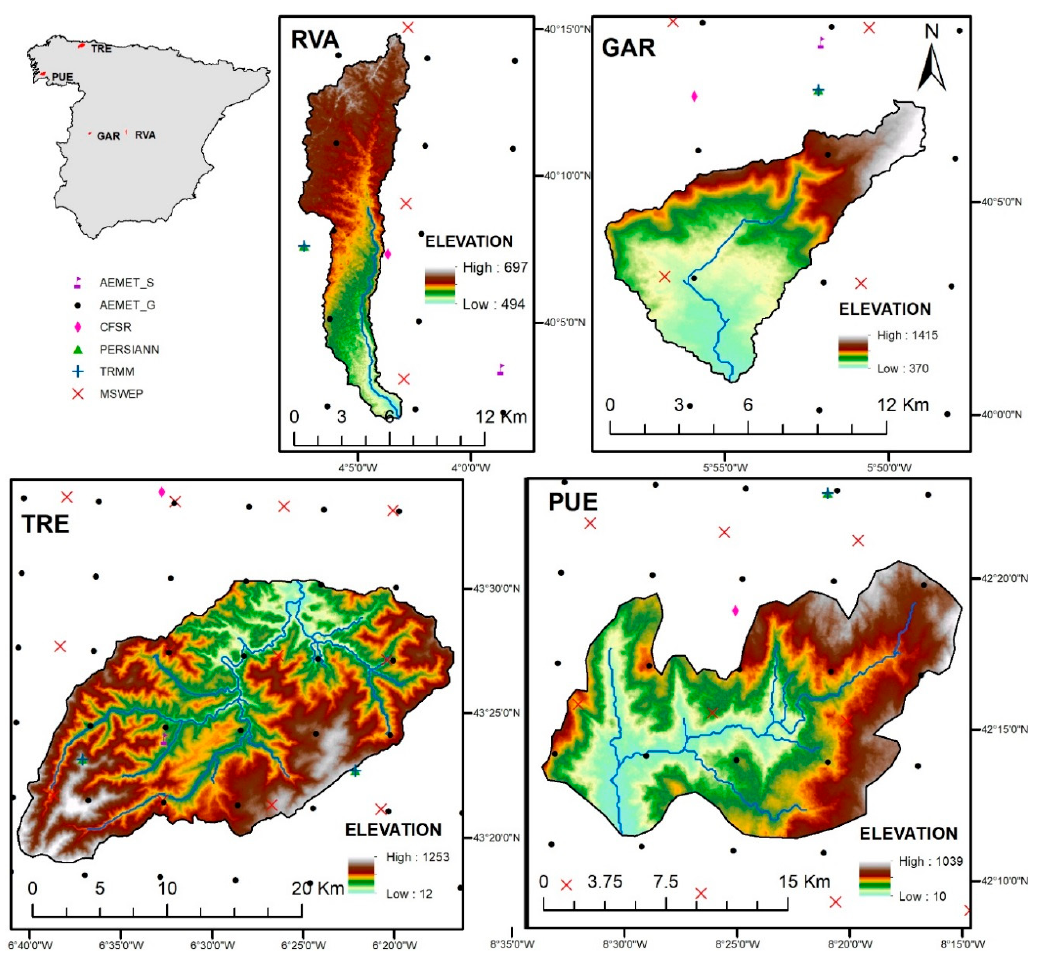
Figure 1. Location, elevation, and gridded precipitation datasets of the selected basins.